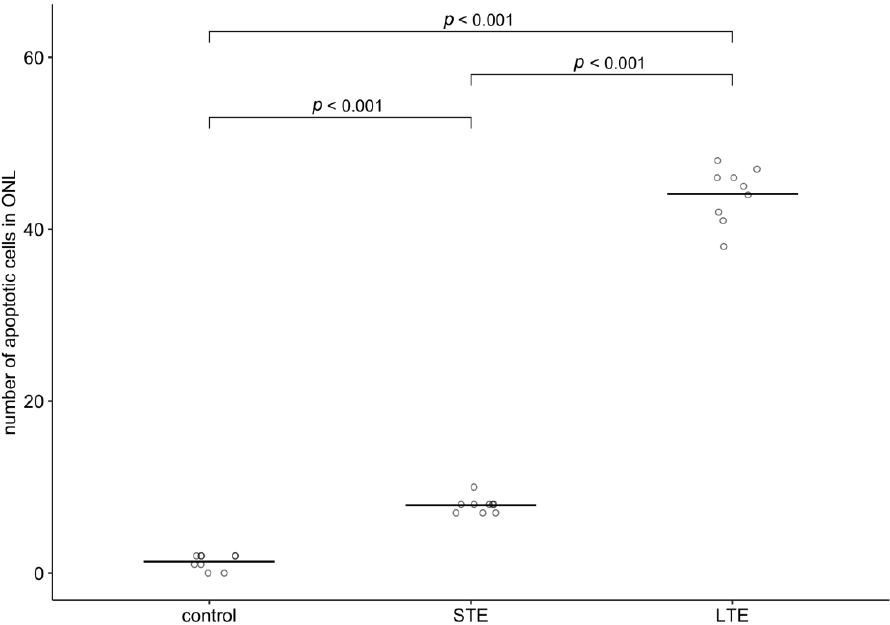
Figure 9. Effect of blue light on the number of apoptotic cells in the outer nuclear layer in Wistar rat retinas. The rats were exposed to 12 h white light (150 lx) and 12 h darkness for 10 d (control, CTRL; 9 rats), cycles of 12 h blue light (150 lx) and 12 h darkness for 10 d (long-term exposure, LTE; 9 rats), and constant blue light (150 lx) for 2 d (short-term exposure, STE; 9 rats). Circles show the intensity of GFAP immunoreactivity in one retinal cryosection; horizontal lines show group means. p -values were calculated by quasi-Poisson regression followed by pairwise comparisons (Tukey’s method for p -value adjustment).